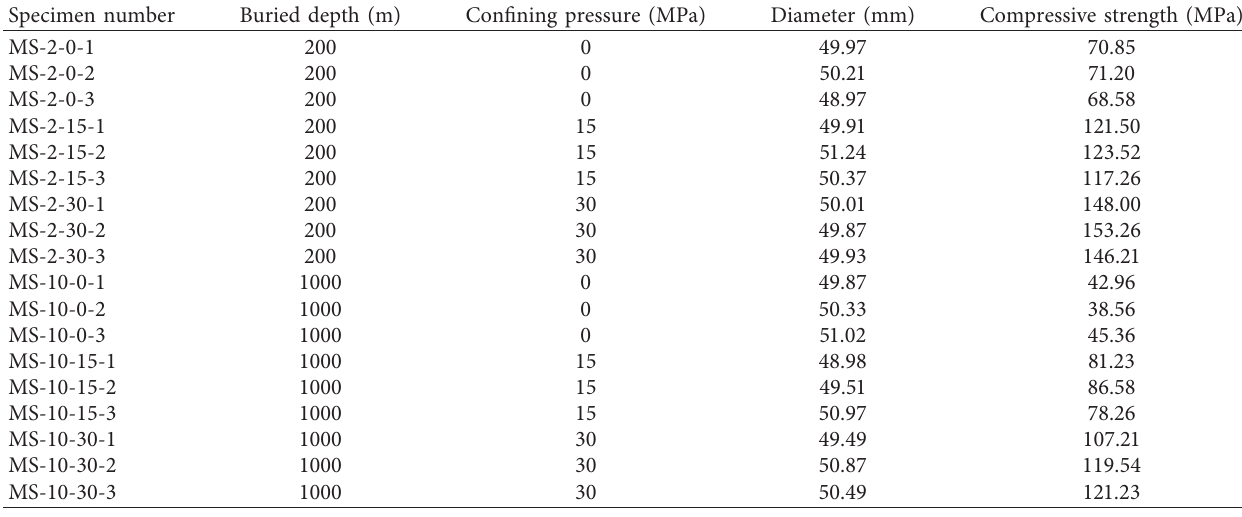
Table 1: Compressive strength of different specimens.